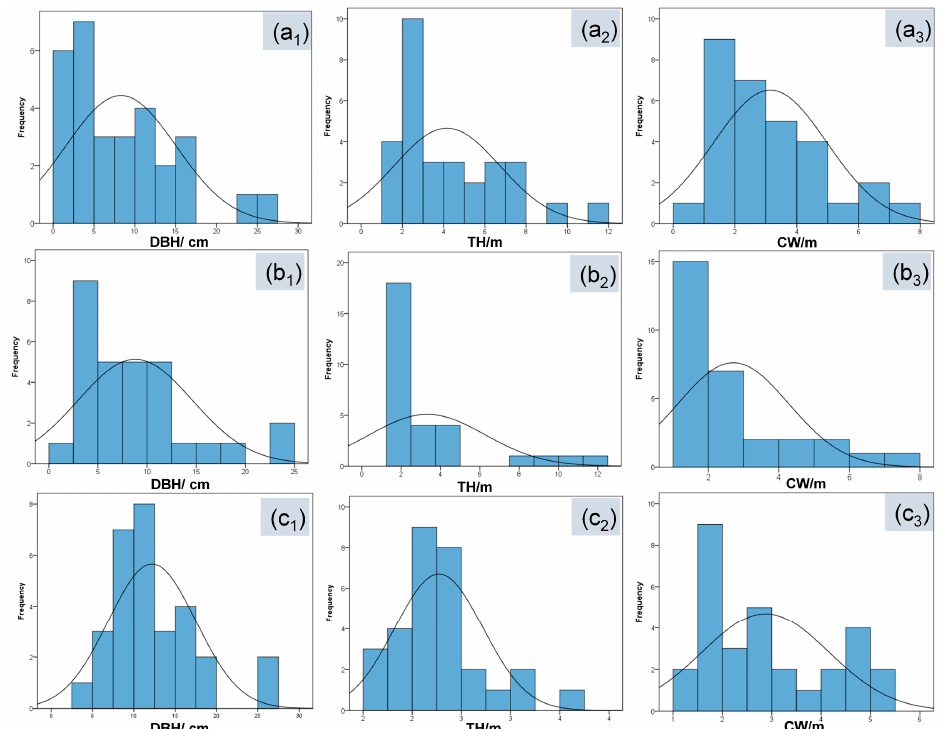
Figure 7. Nonspatial structure in ASV. DBH, TH, and CW in the figure indicate the diameter at breast height (cm), tree height (m), and crown width (m), respectively (the same in the figure below); in addition, ( a 1 – a 3 ) indicate the BJ, ( b 1 – b 3 ) indicate the HJ, ( c 1 – c 3 ) indicate the SB.